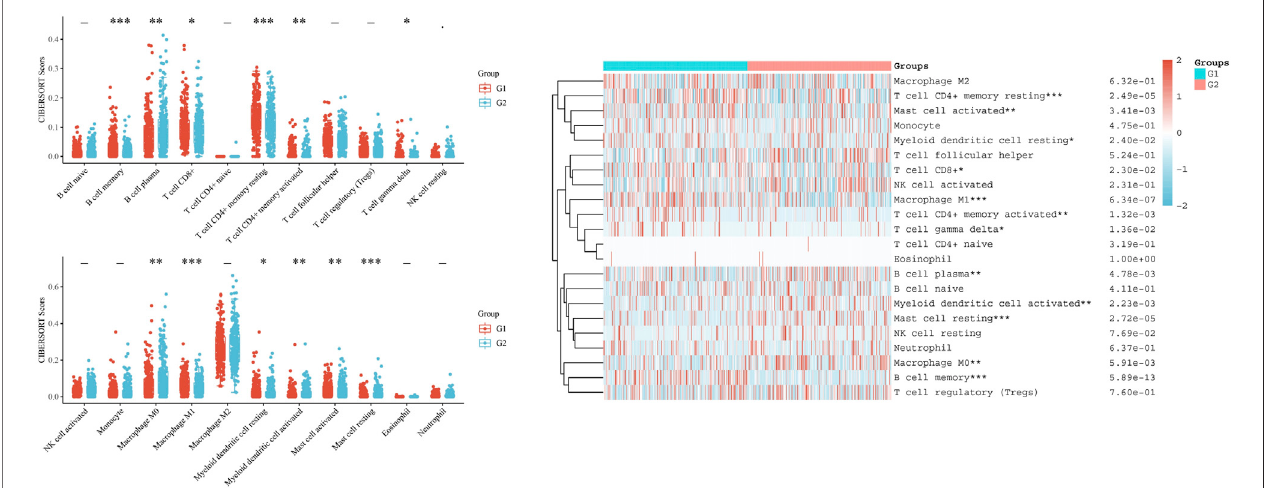
FIGURE 8 | CIBERSORT analysis of TCGA-lung adenocarcinoma (LUAD) dataset. Twenty-two kinds of tumor-in fi ltrating immune cells are plotted according to lymphoid-restricted membrane protein ( LRMP ) expression level. There were signi fi cant differences in memory B cell, plasma B cell, CD8 + T cell, resting memory CD4 + T cell, activated memory CD4 + T cell, gamma delta T cell, M0 macrophage, M1 macrophage, resting myeloid dendritic cell, activated myeloid dendritic, activated mast cell, and resting mast cell (* p < 0.05, ** p < 0.01, *** p <